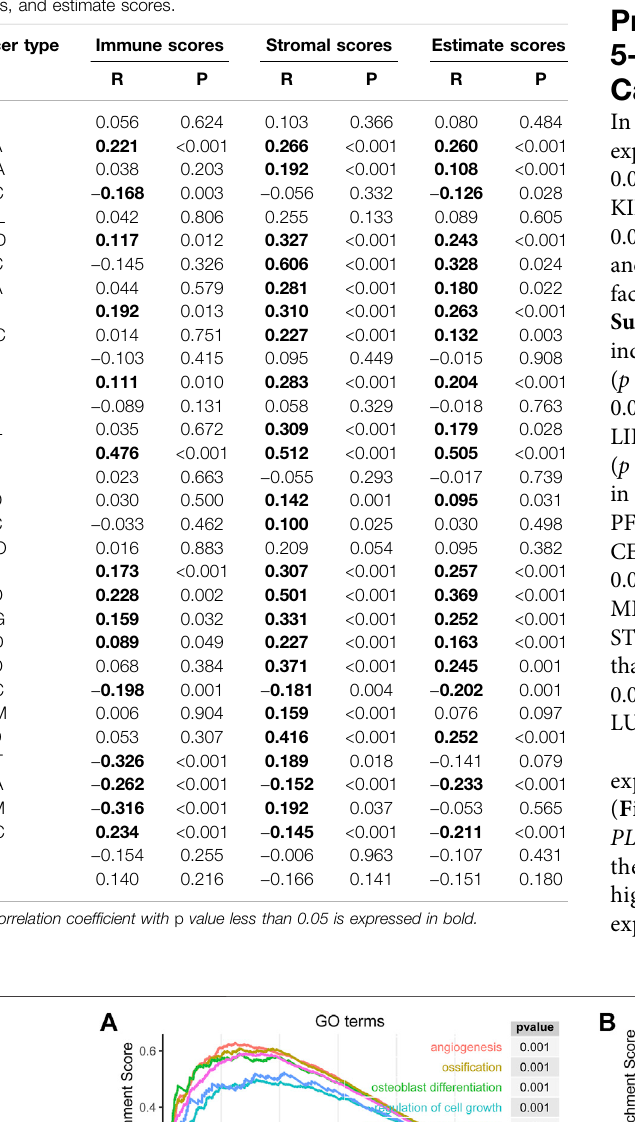
Frontiers in Genetics |